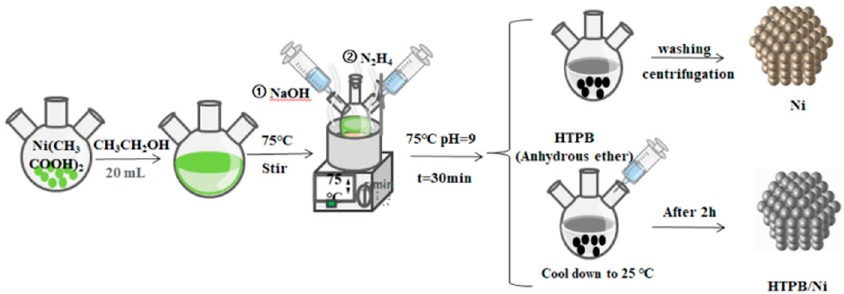
Figure 1. Flow chart of preparation of nNi and HTPB/Ni composite particles. In total, 1.5006 g (0.0085 mol) of Ni(CH 3 COOH) 2 · 5H 2 O was added to 20 mL of anhy- drous ethanol, and dissolved at 75 ◦ C. The pH value of the solution was adjusted to 9 with NaOH. Finally, 13 mL of hydrazine hydrate was added to the system for reduction, keeping the temperature at 75 ◦ C. After 30 min, the system temperature was cooled to 25 ◦ C, and the product was washed three times with anhydrous ethanol and dried at 80 ◦ C for 10 h. nNi (90.6%) was